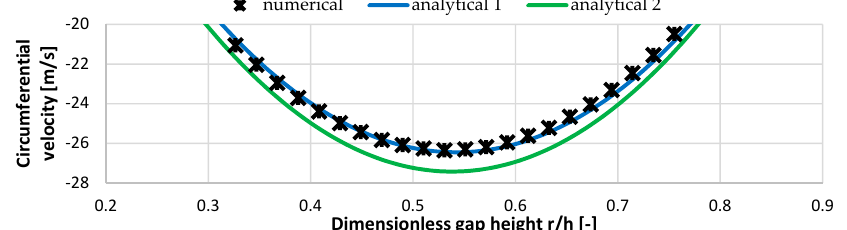
Figure 15. Comparison of the two analytically derived circumferential velocity profiles with the numerical solution at 10-bar delivery pressure and a rotational speed of 4000 rpm in the radial gap